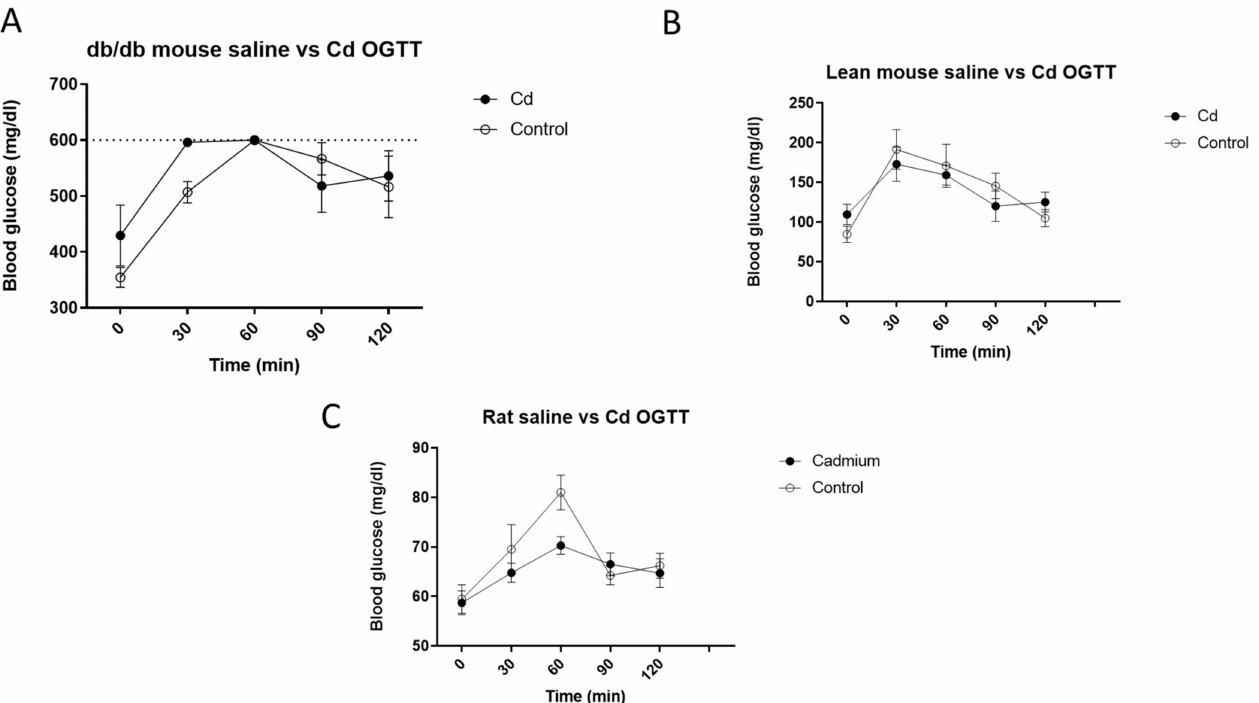
Figure 1. OGTT data following two weeks of 0.6 mg/kg/b.w./day of Cd dosing and two subsequent weeks of no Cd dosing for db/db mice ( A ), lean mice ( B ) and rats ( C ). No statistically significant changes were detected; however, all but one db/db mouse administered Cd had blood glucose levels that exceeded the 600 mg/dL at the 30 min time point, the upper limit of the measuring range of the vsglucose meter (dotted line). Two-way ANOVA with Tukey’s multiple comparison post-tests test; p ≤ 0.05 was considered significant; N = 4 per group for mice and N = 6 for rats per group; data are mean ±